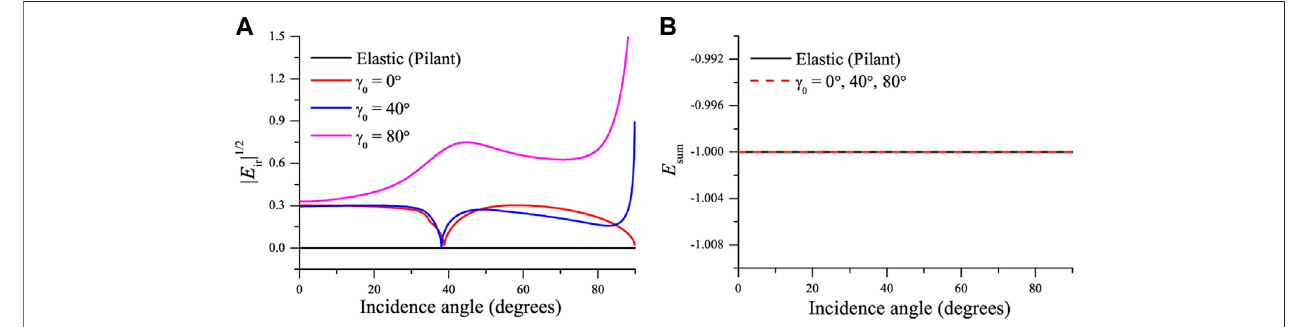
FIGURE 7 | Square root of the interference energy (A) and the sum of the energy ratios (energy balance) (B) for an incident P wave (see Figure 4 ).